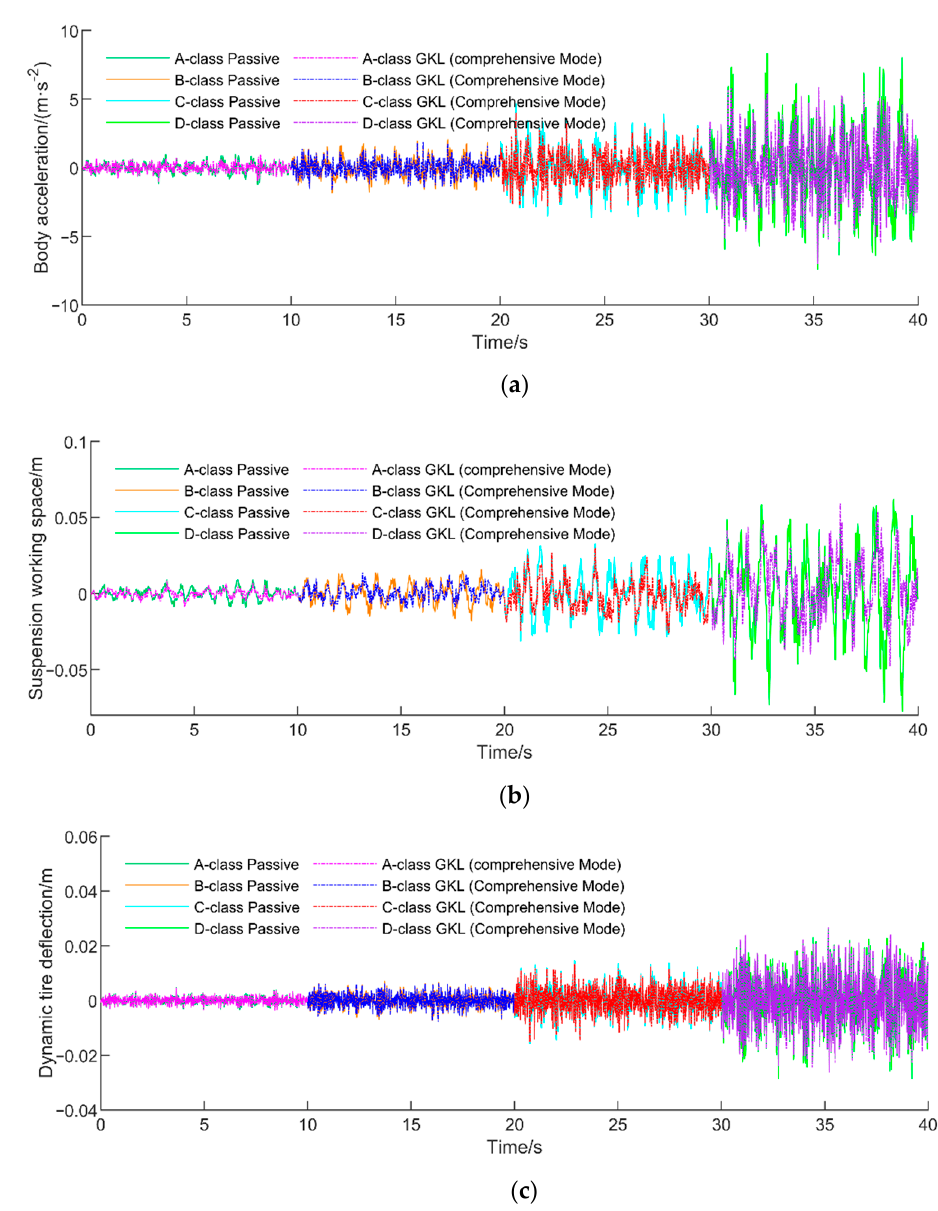
Figure 13. Comparison curves of time domain response for two suspensions (passive suspension and comprehensive mode of active suspension): ( a ) BA; ( b ) SWS; ( c ) DTD. Table 14. RMS values and improvement rate of performance indexes for comprehensive mode. Road Class